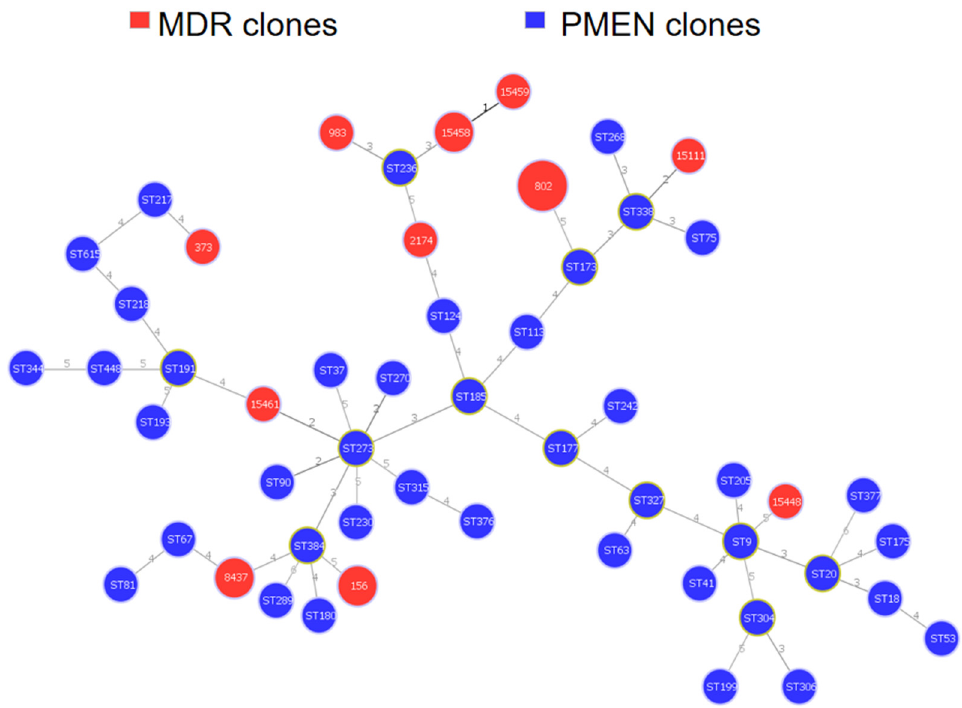
Figure 4. MLST comparison of the genetic relatedness of MDR strains with PMEN clones. The red color represents STs of MDR strains from this study. The blue color shows the PMEN STs obtained from the PMEN database. Diameters of the nodes are proportional to the number of isolates. Founding STs have a yellow color around their nodes. Branch labels correspond to the number of allelic variations between STs; branch lengths are not to scale.